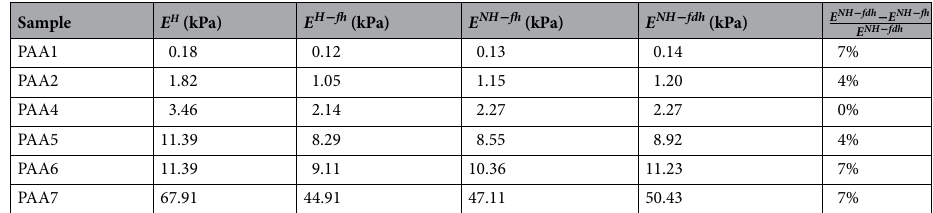
Table 2. Elastic modulus estimated from the classical Hertz theory E H , Hertz theory corrected for finite height E H-fh , Hertz theory corrected for neo-Hookean non-linearity and finite height E NH-fh , Hertz theory corrected for neo-Hookean nonlinearity and finite dimensions (finite height and finite diameter) E NH-fdh .